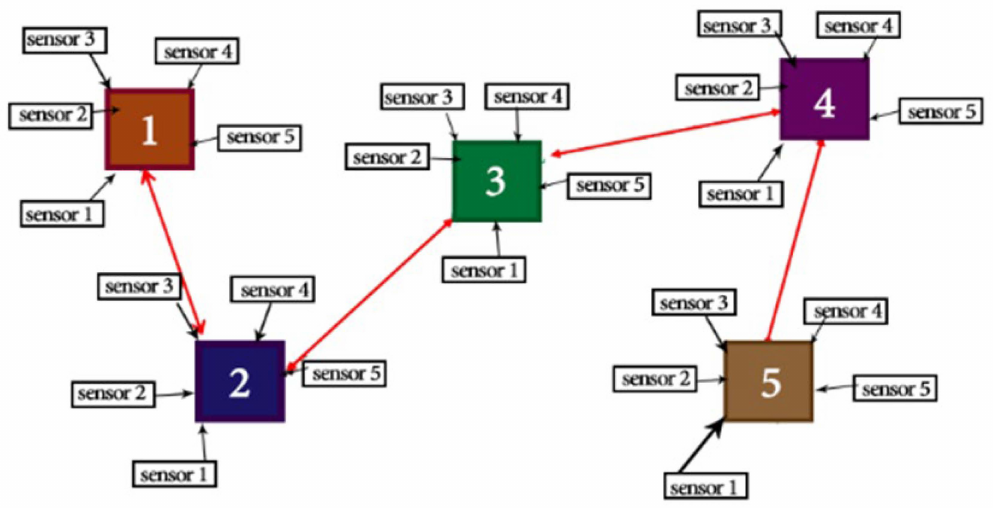
Figure 7. Incorporation of a blockchain approach into the structure of a WSN.